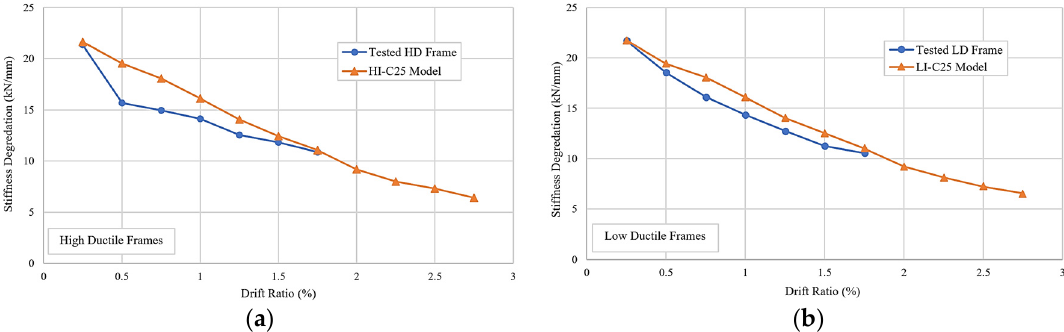
Figure 17. Stiffness degradations of the tested frames and models: ( a ) HD frames; ( b ) LD frames.